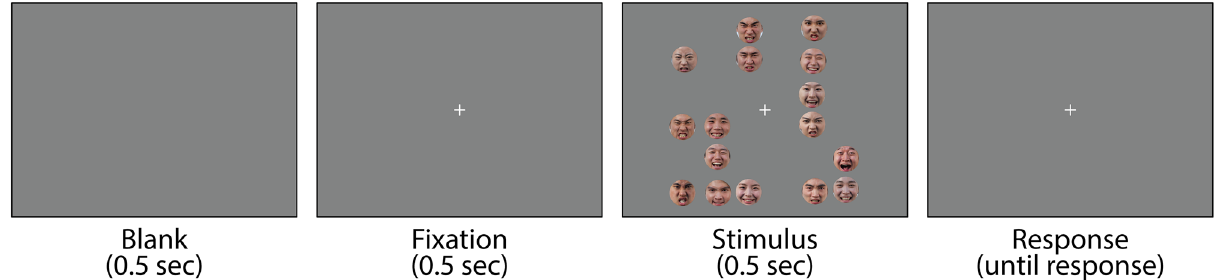
Figure 1. Illustration of the experimental procedure. Following a central fixation, a crowd with 16 emotional faces was presented to the participants. Participants’ task was to determine which positive or negative emotional faces were more numerous in the stimulus